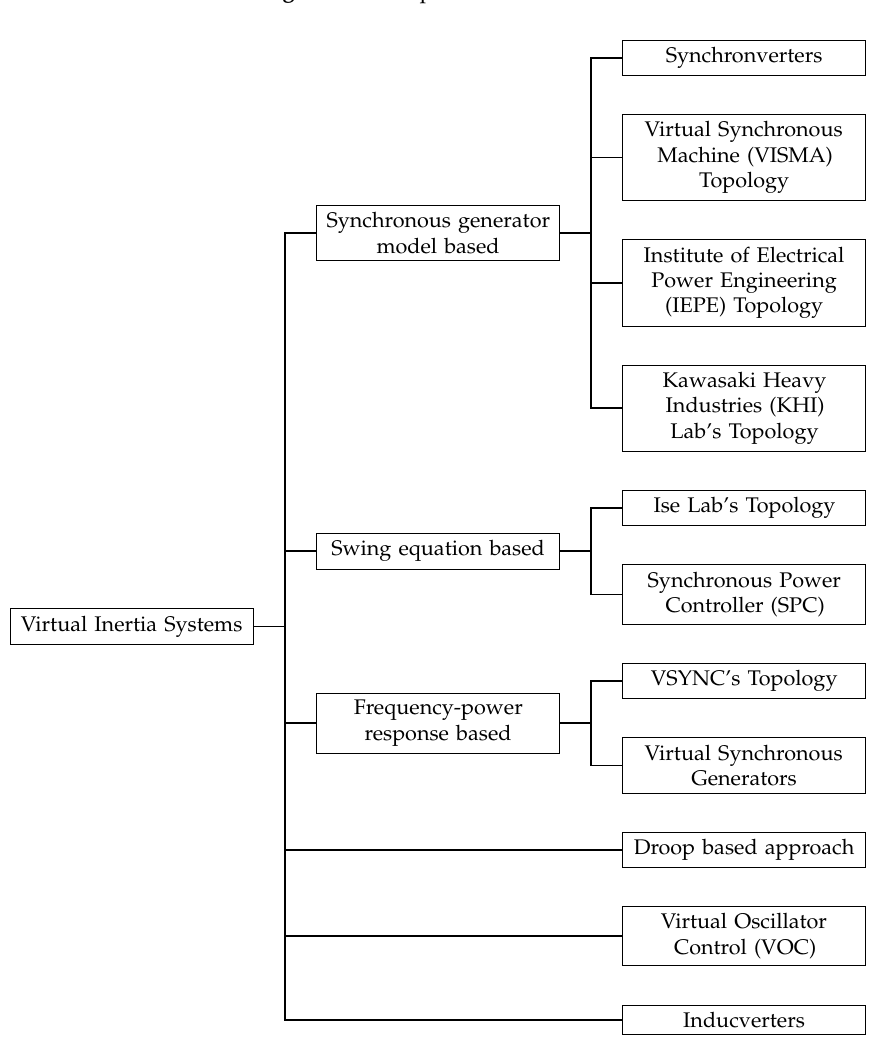
Figure 6. Classification of different topologies used for virtual inertia